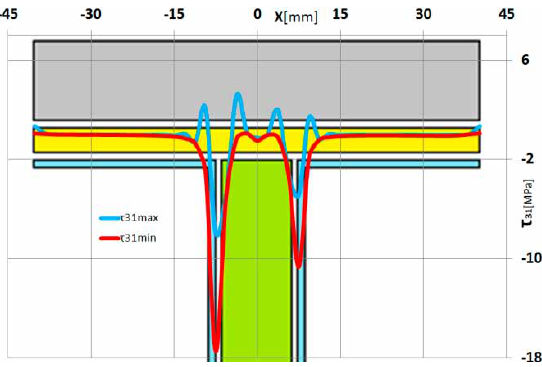
Fig. 9. Peaks of τ 31 due to shear force in the glue